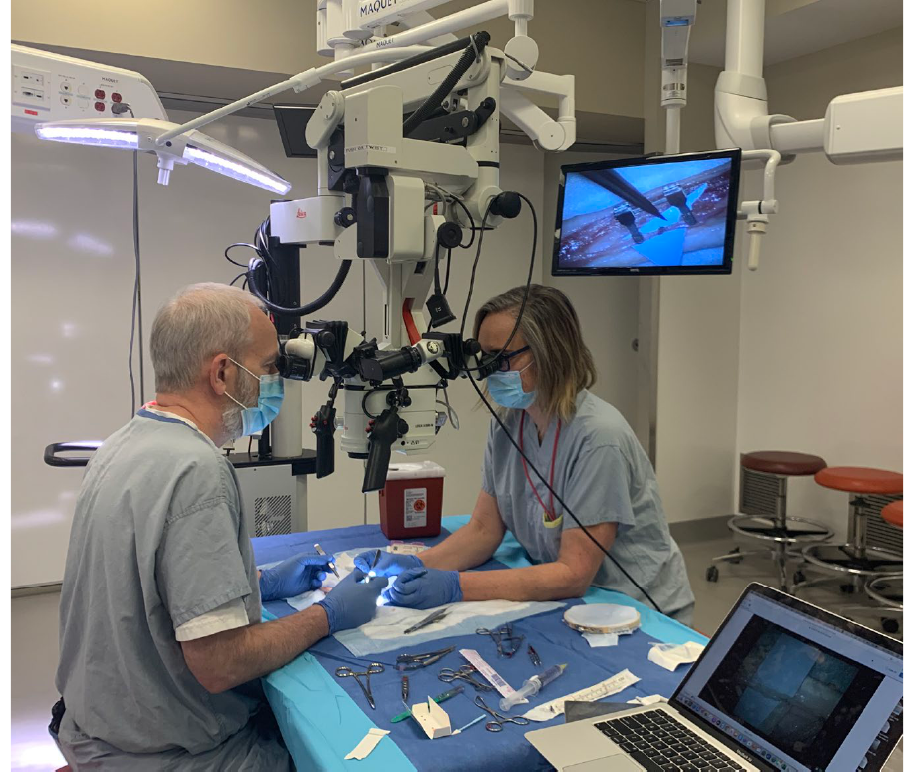
Figure 5. Oncologic and plastic surgeons train together in the ATSSL simulation lab in Calgary.